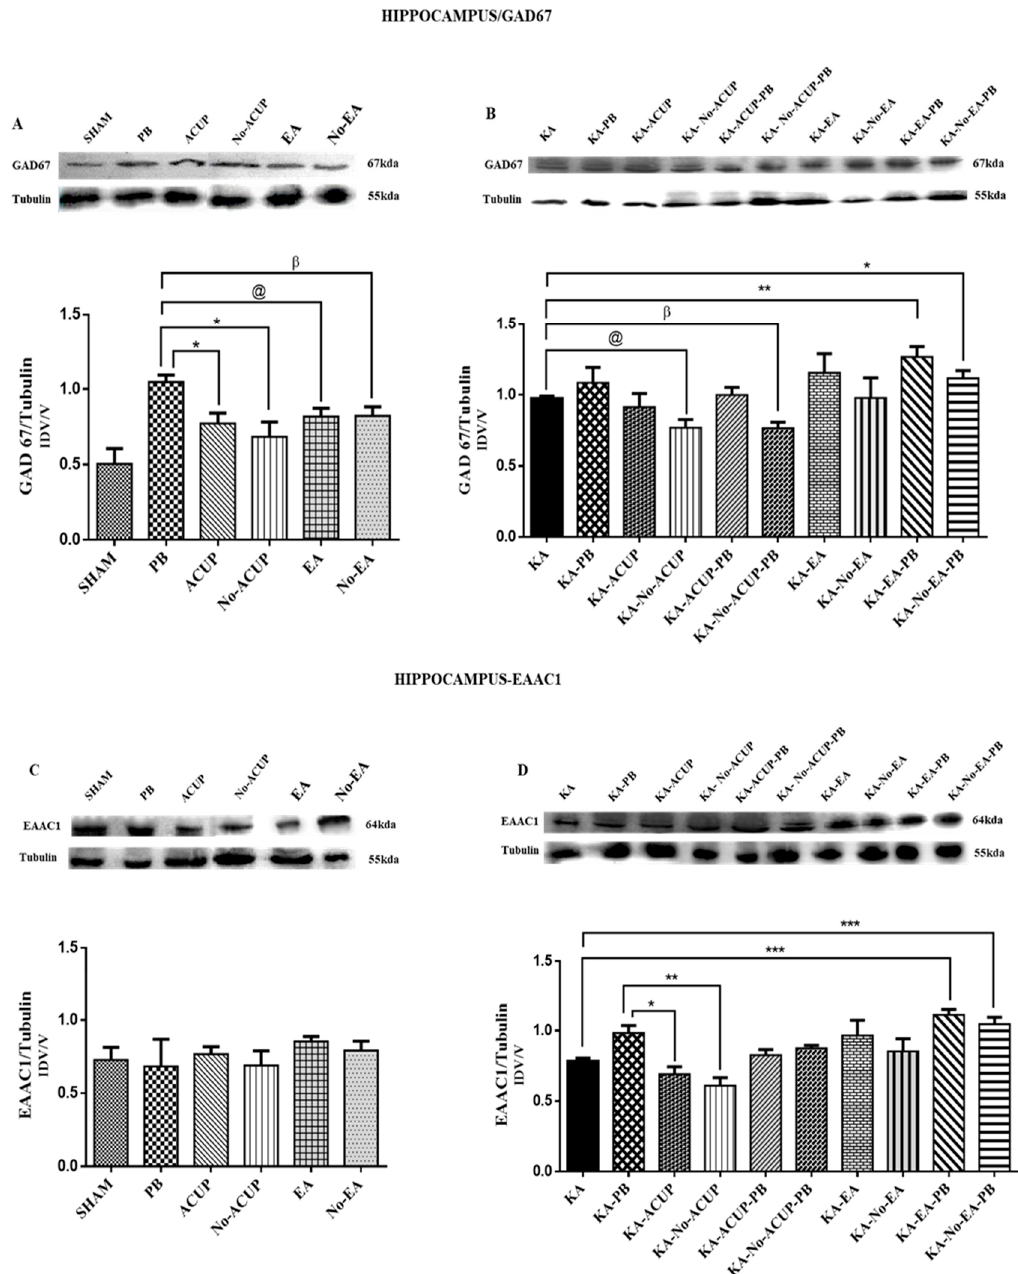
Figure 4. ( A ) Graph showing the expression of GAD67 in the hippocampus. The PB group showed a significant increase in GAD67 expression as compared with the ACUP, No-ACUP, EA, and No-EA groups (* p < 0.0160, * p < 0.0024, @ p < 0.0187 and β p < 0.0246). ( B ) The experimental groups KA-EA-PB and KA-No-EA-PB showed a significant di ff erence (** p < 0.001 and * p < 0.01) as compared with the KA group; in the same way the KA-No-ACUP and KA-No-ACUP-PB showed a significant di ff erence (@ p < 0.01, β p < 0.001) with the KA group. One-way ANOVA followed by a Bonferroni’s post hoc test, p < 0.05. ( C ) Graph showing the expression of EAAC1 in the hippocampus; no significant di ff erences were observed among the control groups. ( D ) The experimental and placebo groups, KA-ACUP, and KA-No-ACUP, were significantly lower than the KA-PB group (* p < 0.0076 and ** p < 0.0015) and KA-EA-PB, KA-No-EA-PB were increased significantly as compared with the KA group (*** p < 0.001 and *** p < 0.01, respectively). One-way ANOVA followed by a Bonferroni’s post hoc test, p < 0.05.